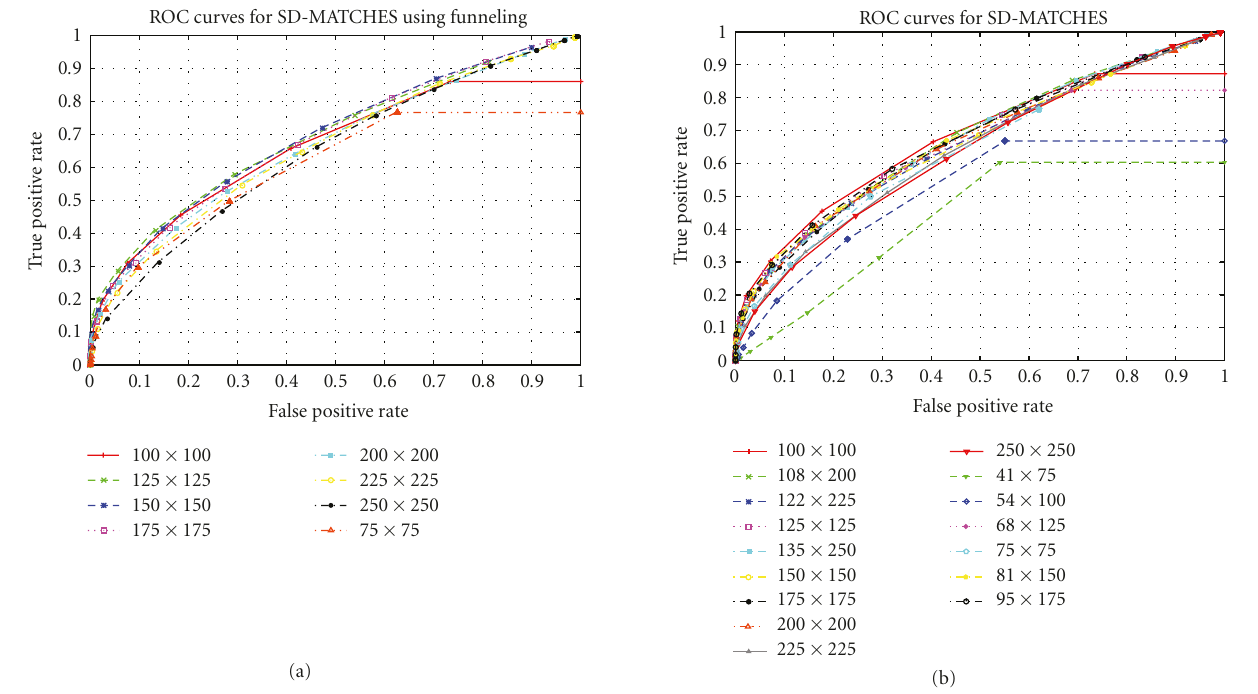
Figure 7: E ff ect of the image’s region size on the performance of SD-MATCHES method. (a) Faces aligned using funneling, (b) unaligned